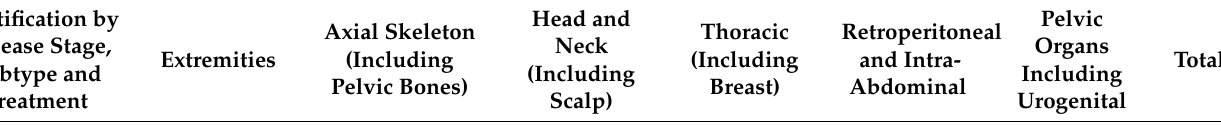
Table 1. Stratification matrix phase 1a and